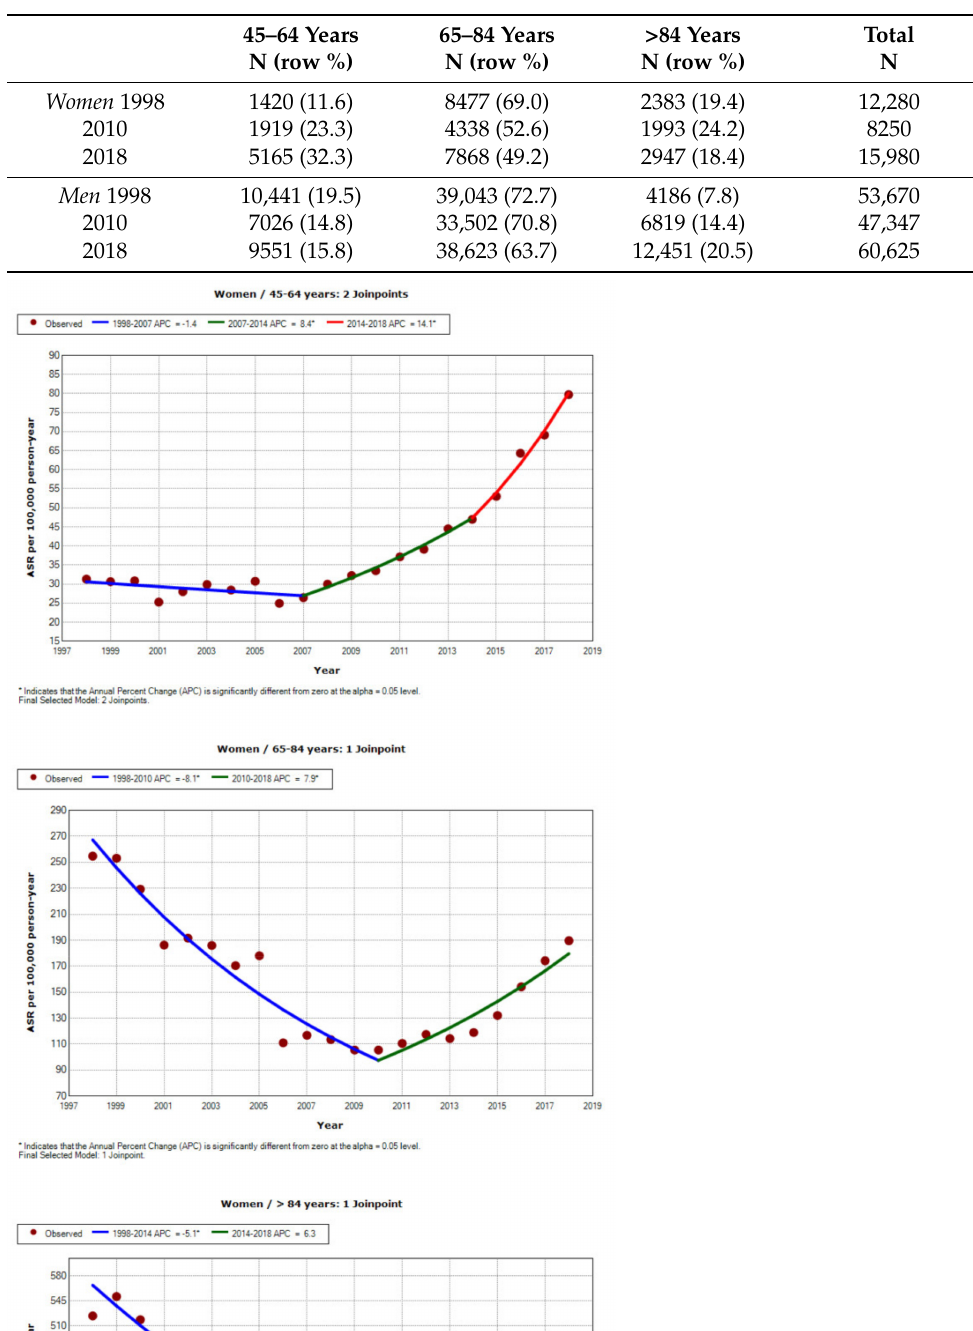
Table 4. Evolution of hospital admissions due to COPD in Spain, by gender and age group.